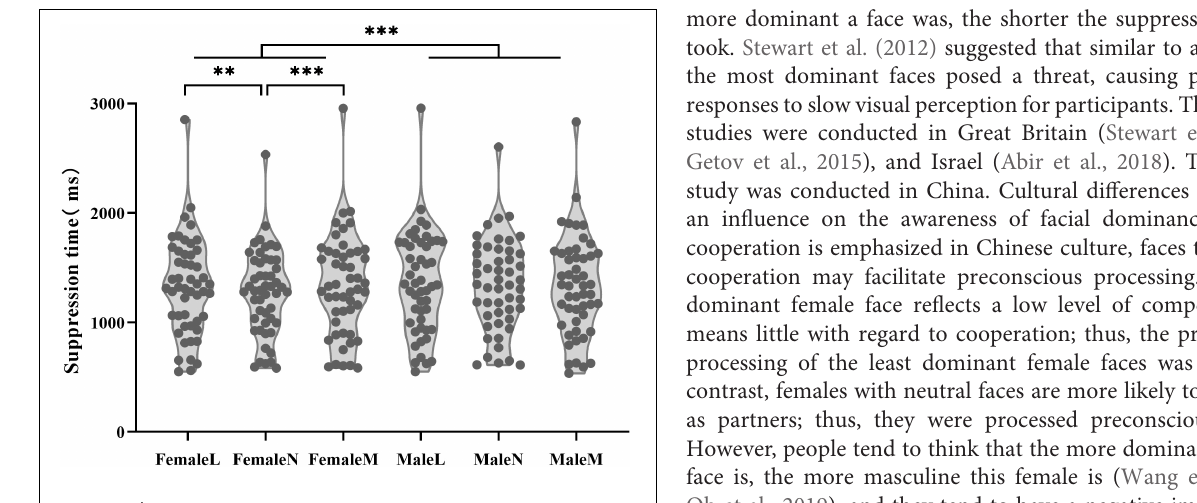
FIGURE 4 | The results of Experiment 2: The plot shows the suppression time of the participants for the least dominant, neutral and the most dominant faces of different genders (male and female faces). ∗∗ p < 0.01, ∗∗∗ p < 0.001. In the figure, FemaleL means the female least dominant faces, FemaleN means the female neutral faces, FemaleM means the female most dominant faces, MaleL means the male least dominant faces, MaleN means the male neutral faces, MaleM means the male most dominant